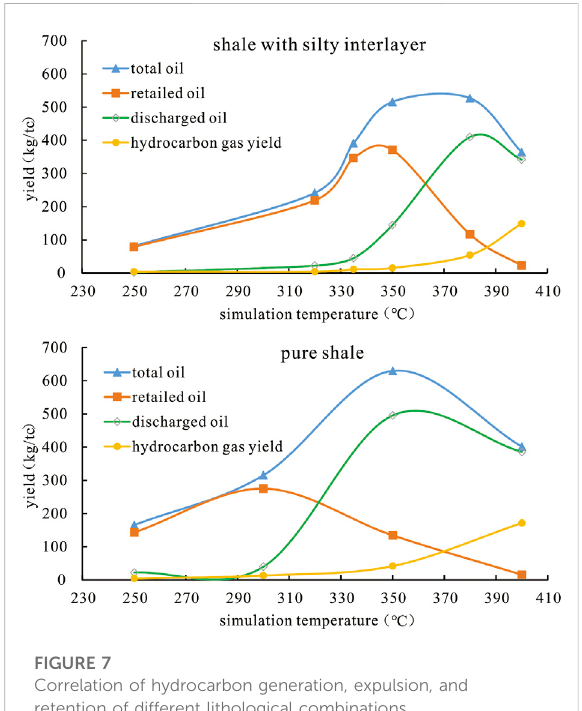
FIGURE 7 Correlation of hydrocarbon generation, expulsion, and retention of different lithological